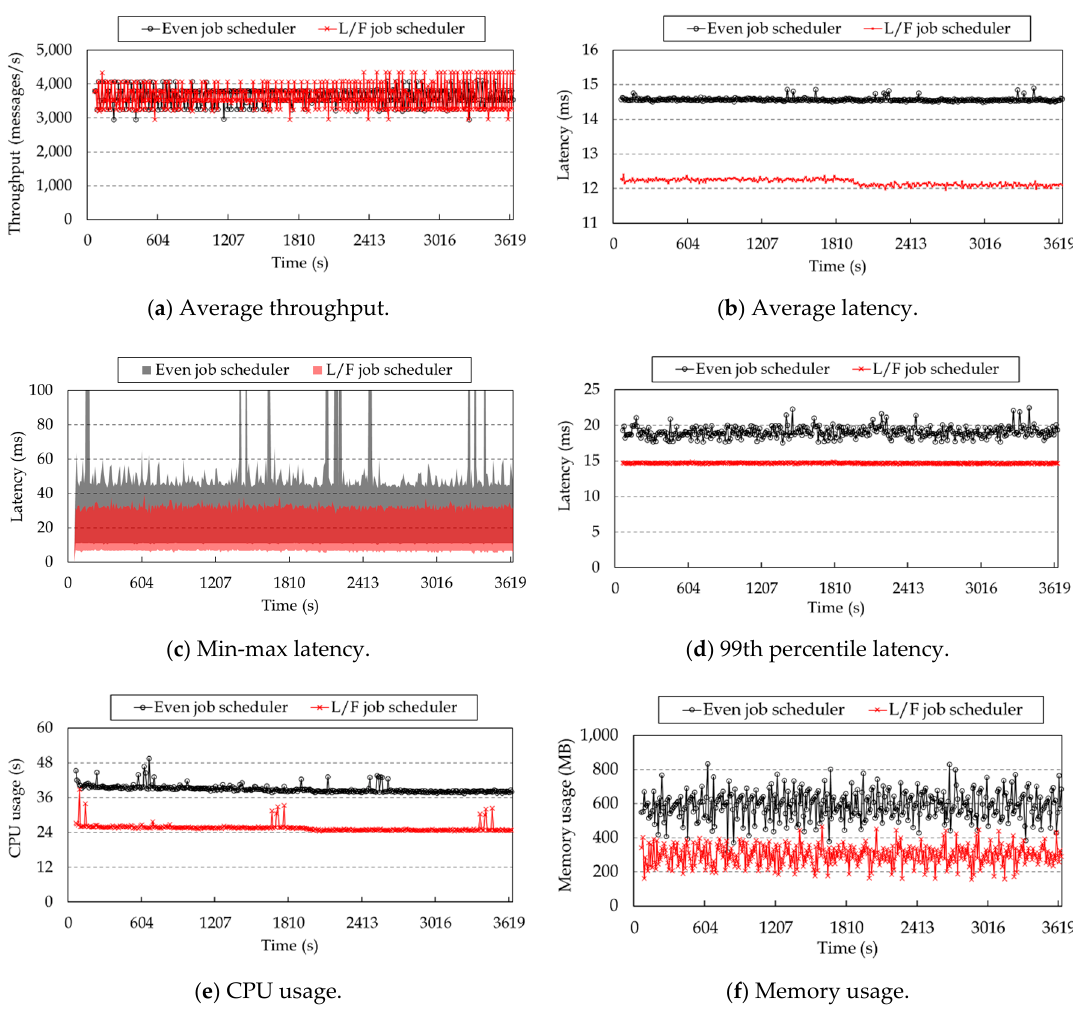
Figure 12. Performance of even and L/F job schedulers on simple page view count.